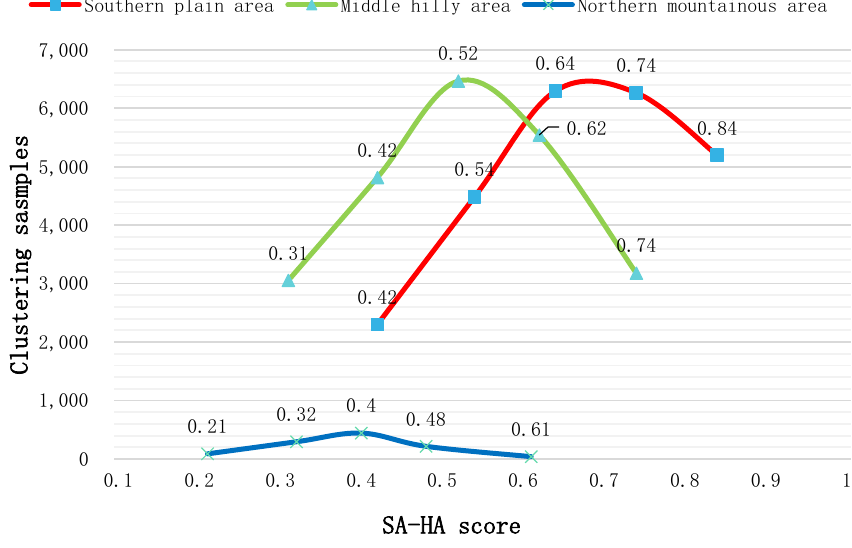
Figure 6. Clustering scores of the coupling coordination index of SA-HA.